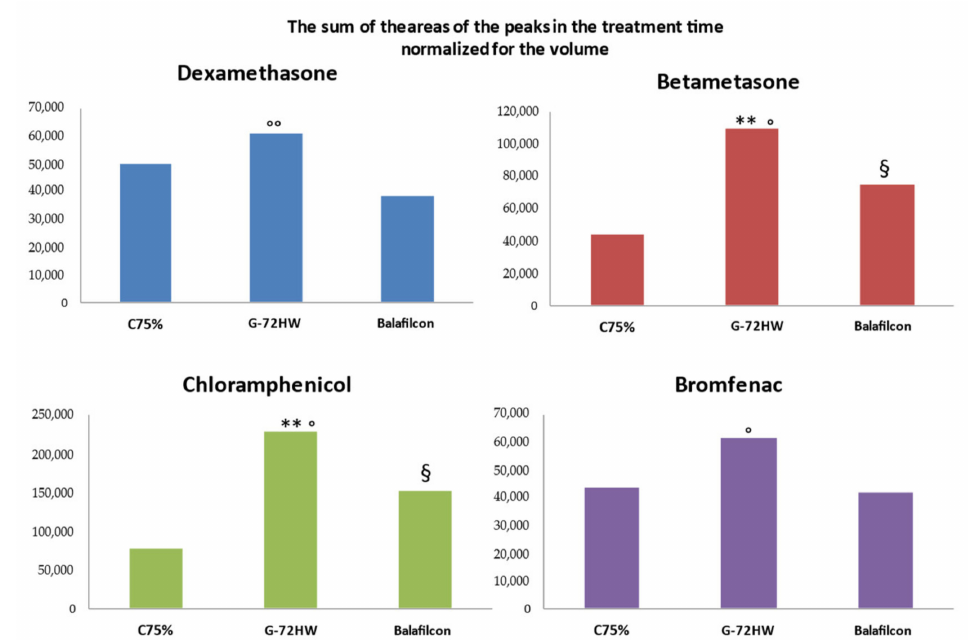
Figure 2. Average passage of tested drugs through the lenses at all time points tested. ** p < 0.01 G-72HW vs. C75%. ◦ p < 0.05 G-72 HW vs. Balafilcon A. § p < 0.05 Balafilcon Avs